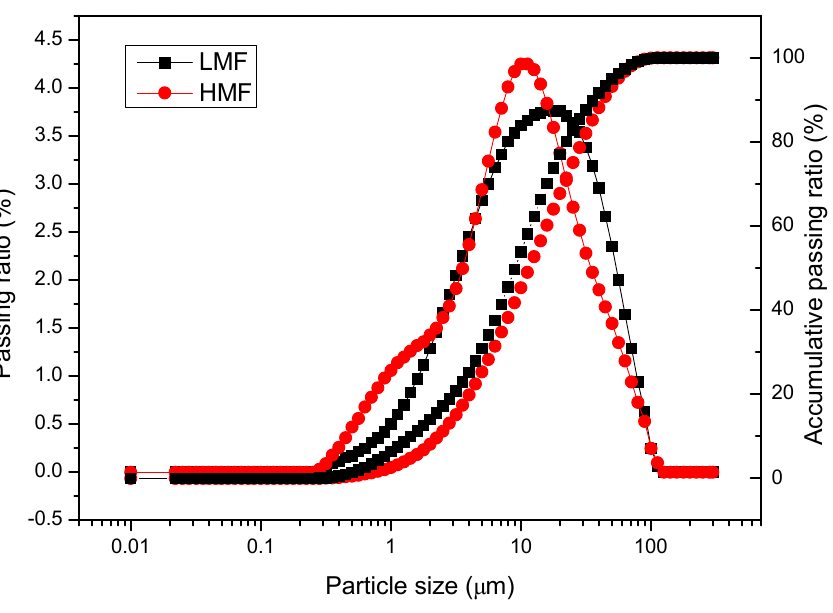
criterion of maximum RV value (50%). HMF with a higher RV value indicated less free asphalt and thus higher mastic stiffness.